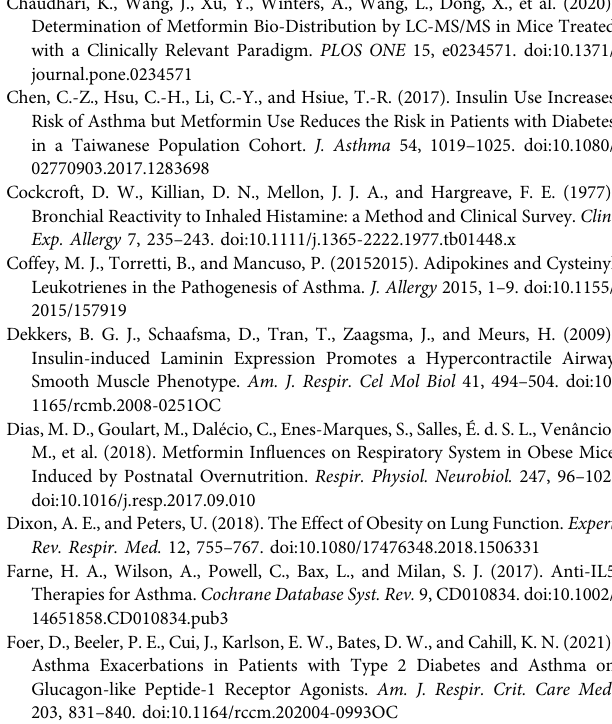
Supplementary Table S1 | Raw data of insulin ELISA. Supplementary Table S2 | Raw data of Methacholine Challenge